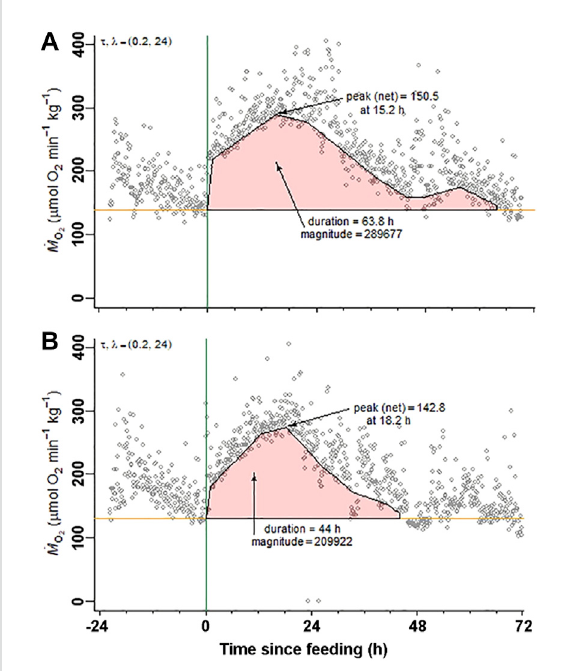
FIGURE 2 Nile tilapia ( Oreochromis niloticus ) Speci fi c Dynamic Action